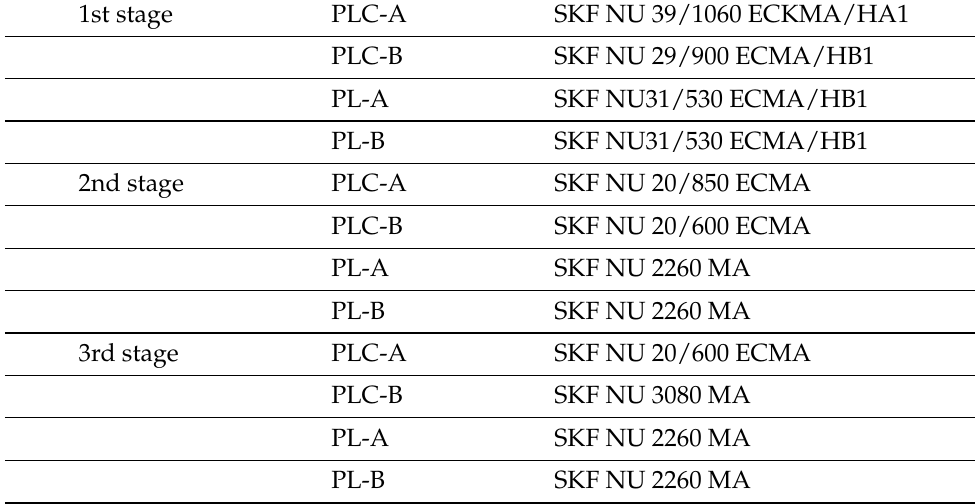
Table 8. Bearings overview